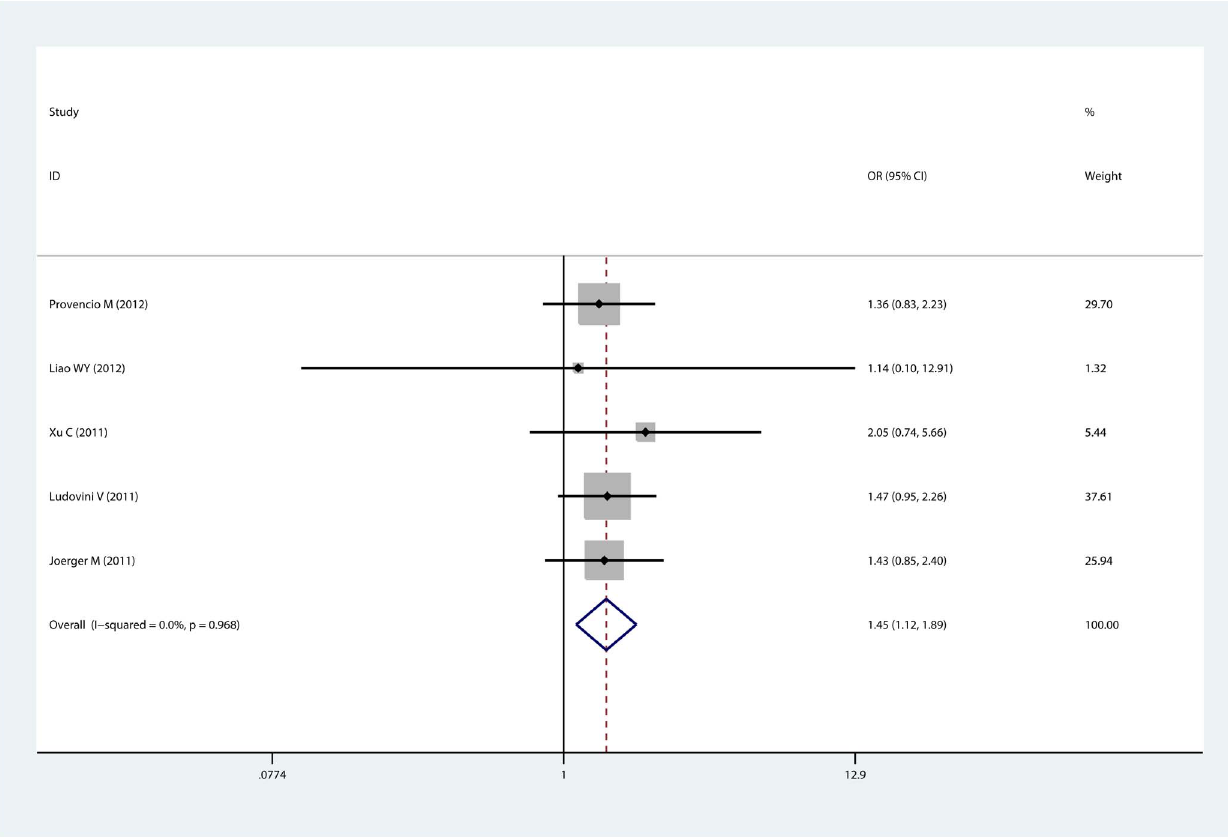
Figure 2. Forest plot of the comparison of Mer vs. Thr for response to platinum-based chemotherapy. OR=1.453, 95% CI: 1.116–1.892, p=0.968 for heterogeneity.